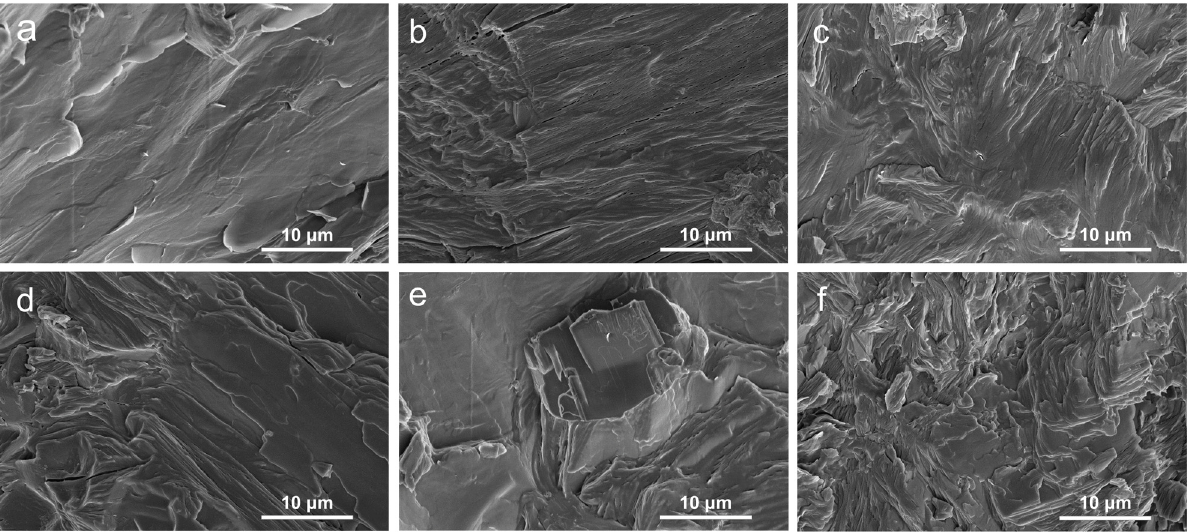
Figure 1. SEM images of the fracture surface of ( a ) PEG/WF, ( b ) PEG/WF/6.0APP@4.0OMMT, ( c ) ( c ) PEG/WF/8.0APP@2.0OMMT, ( d ) PEG/WF/9.0APP@1.0OMMT, ( e ) PEG/WF/10.0APP, and PEG/WF/8.0APP@2.0OMMT, ( d ) PEG/WF/9.0APP@1.0OMMT, ( e ) PEG/WF/10.0APP, and ( f ) PEG/WF/10.0OMMT composites. ( f ) PEG/WF/10.0OMMT